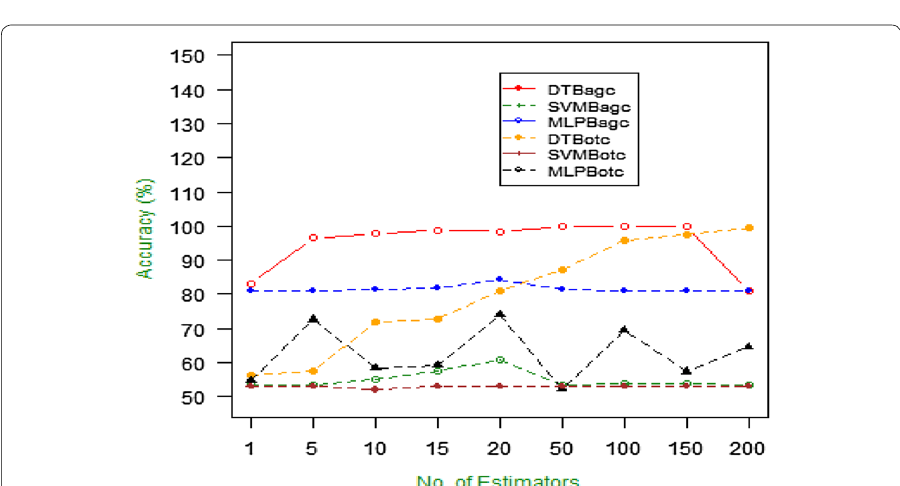
Fig. 9 Bagging and boosting classifiers accuracy over the JSE